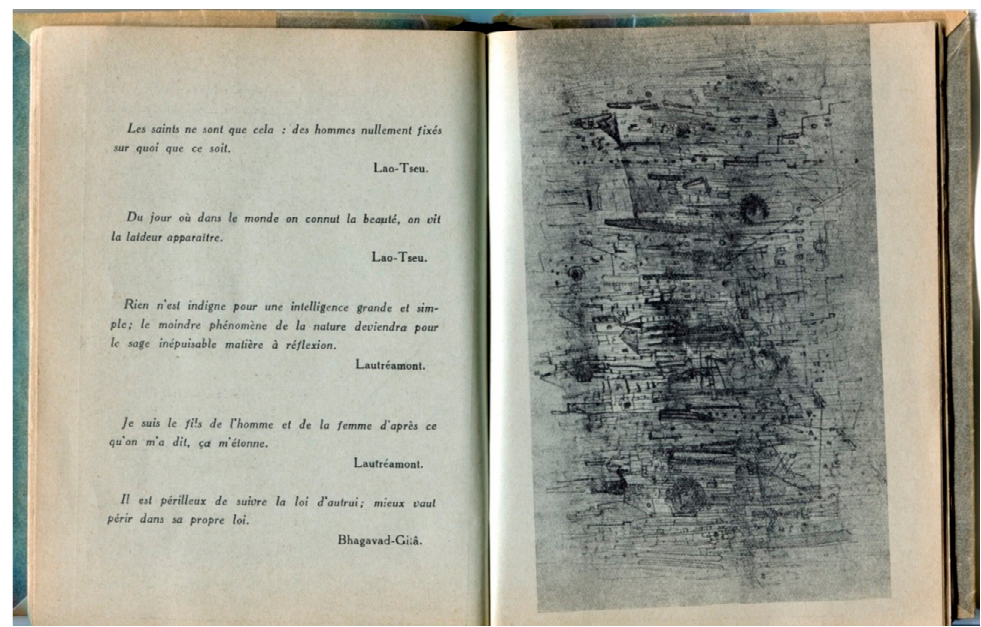
Figure 8. Double page from the catalog Wols , gallery Drouin, 1945. Paris: Jean Belmont/Galerie Drouin [np]. Collection of the author.